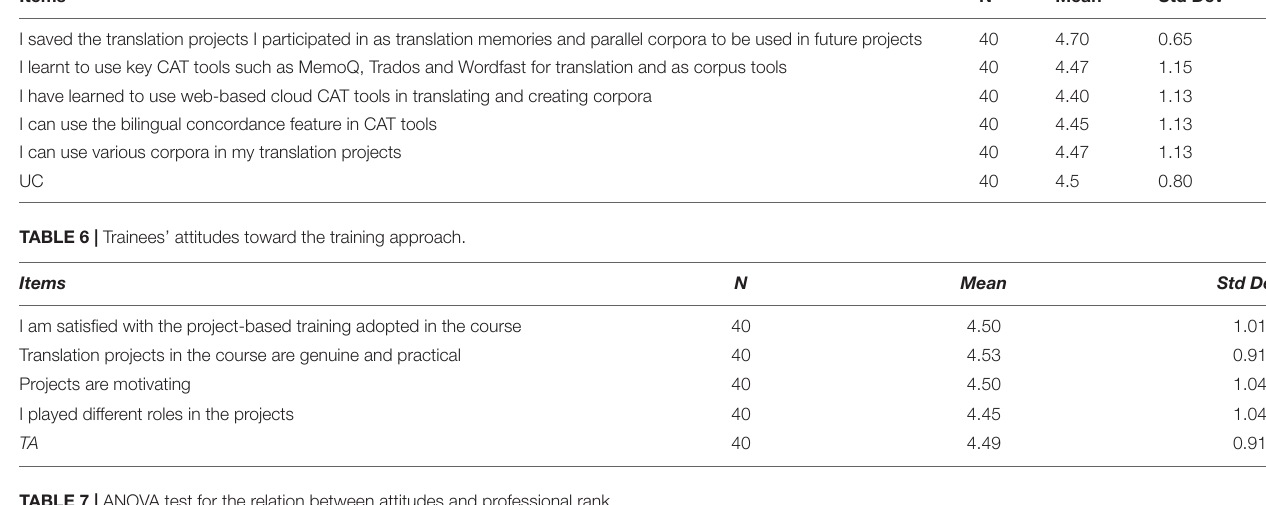
TABLE 5 | Trainees’ attitudes toward the use of corpora. Items N Mean Std Dev